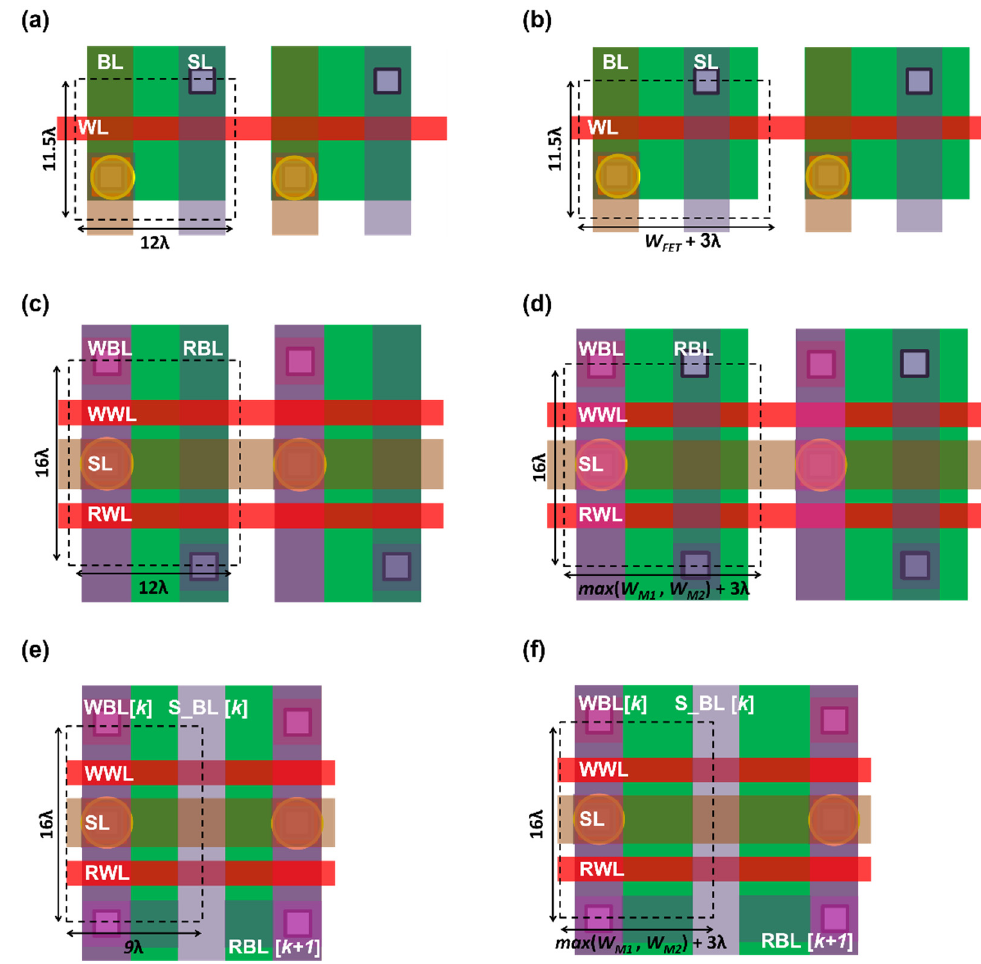
Figure 9. Single-port STT-MRAM layout ( a ) when the access transistor width is smaller than 9 λ , ( b ) when its access transistor width is greater than 9 λ , conventional 1R/1W STT-MRAM layout ( c ) when width of both transistors is smaller than 9 λ , ( d ) when width of either of M1 and M2 is greater than 9 λ , proposed 1R/1W STT-MRAM layout ( e ) when width of both transistors is smaller than 6 λ , ( f ) when width of either of M1 and M2 is greater than 6 λ .